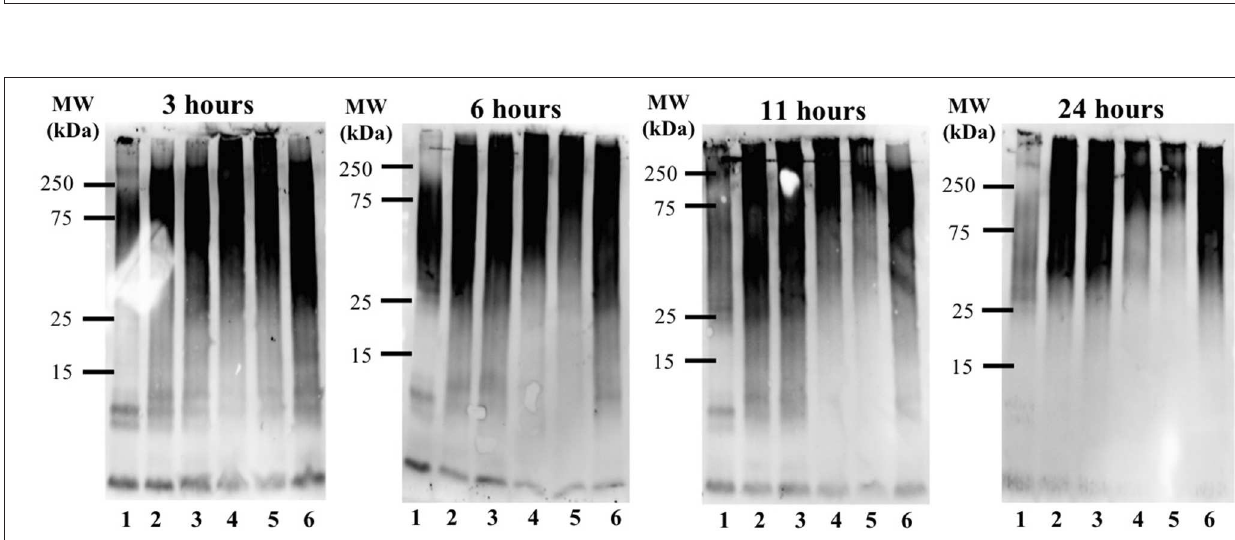
Frontiers in Chemistry | www.frontiersin.org